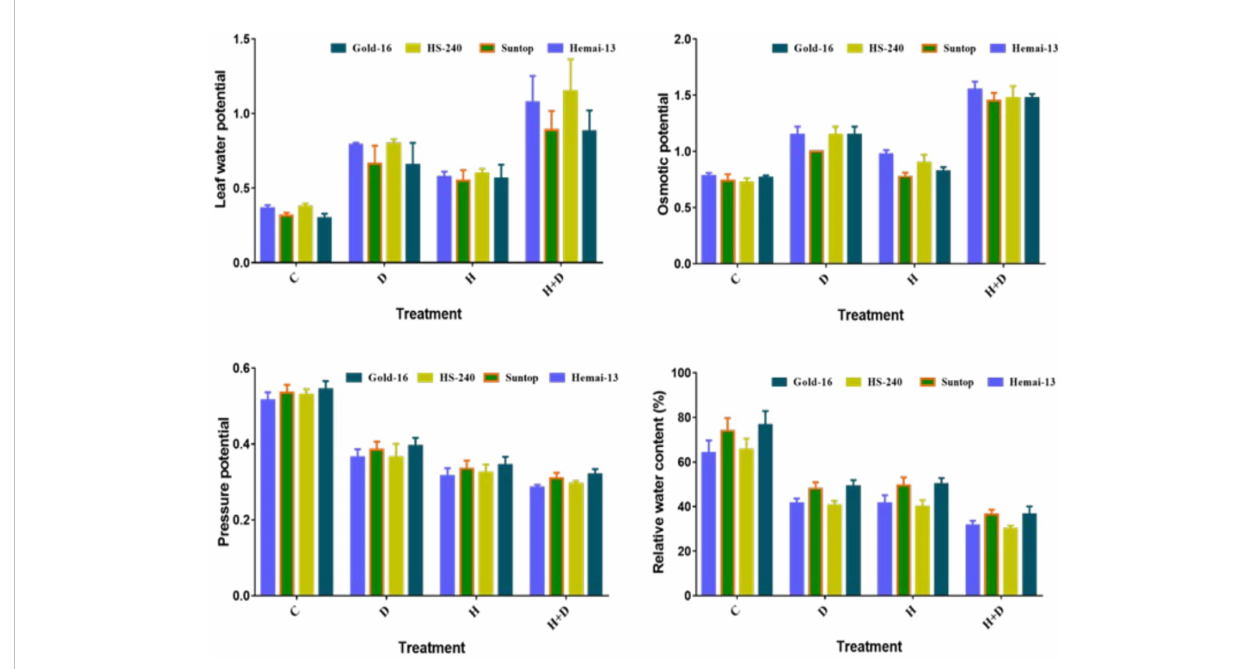
FIGURE 3 Variation in plant – water relations of wheat genotypes due to individual and combined treatments of drought and heat stress. Leaf water potential ( y w ); osmotic potential ( y s ); pressure potential ( y p ); relative water content (RWC). Values in the graph are means averaged after every 4 days of treatment application during the two-factorial tri-replicate experiment at a p -value ≤ 0.05. *Units: y w ( – MPa); y s (MPa); y p